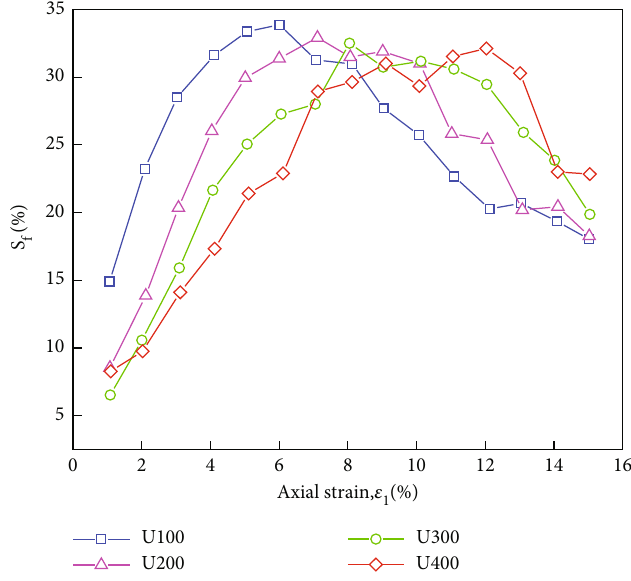
Figure 10: Evolution of sliding contact ratio without considering particle